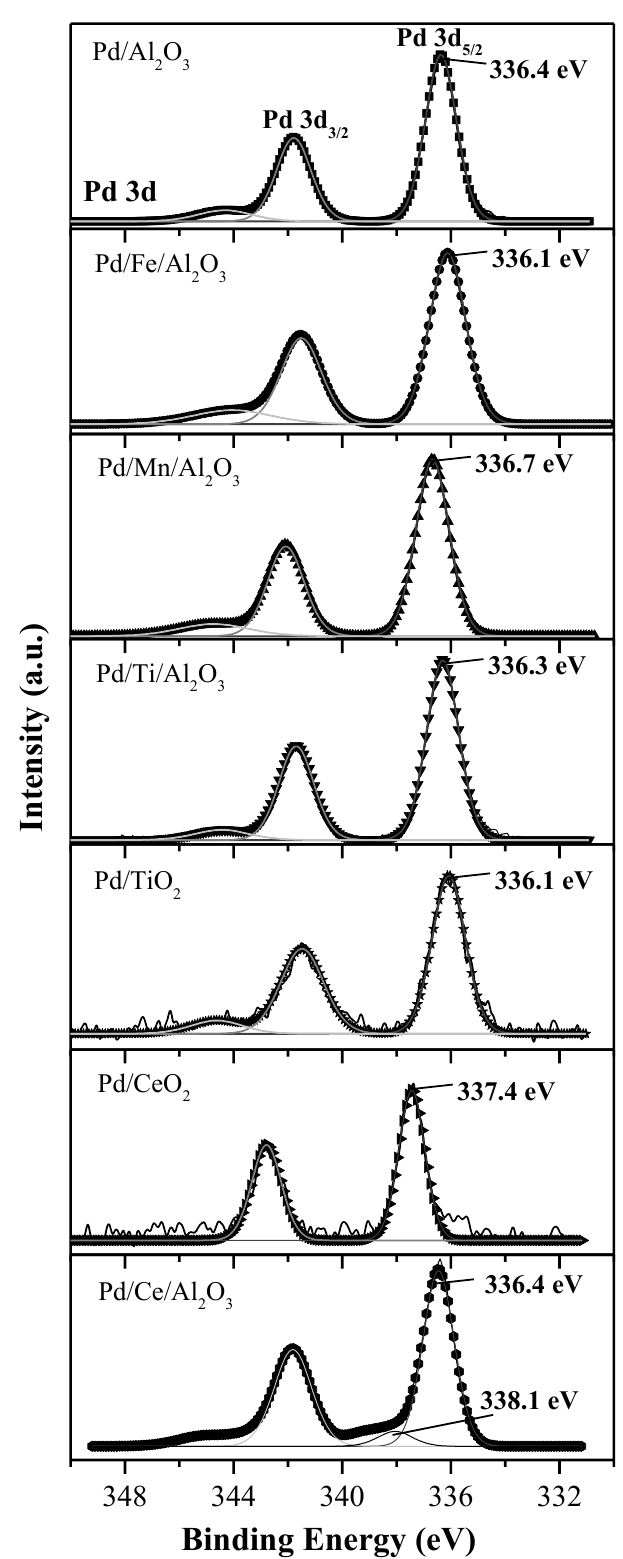
Figure 7. Pd 3d XPS spectra of Pd-supported